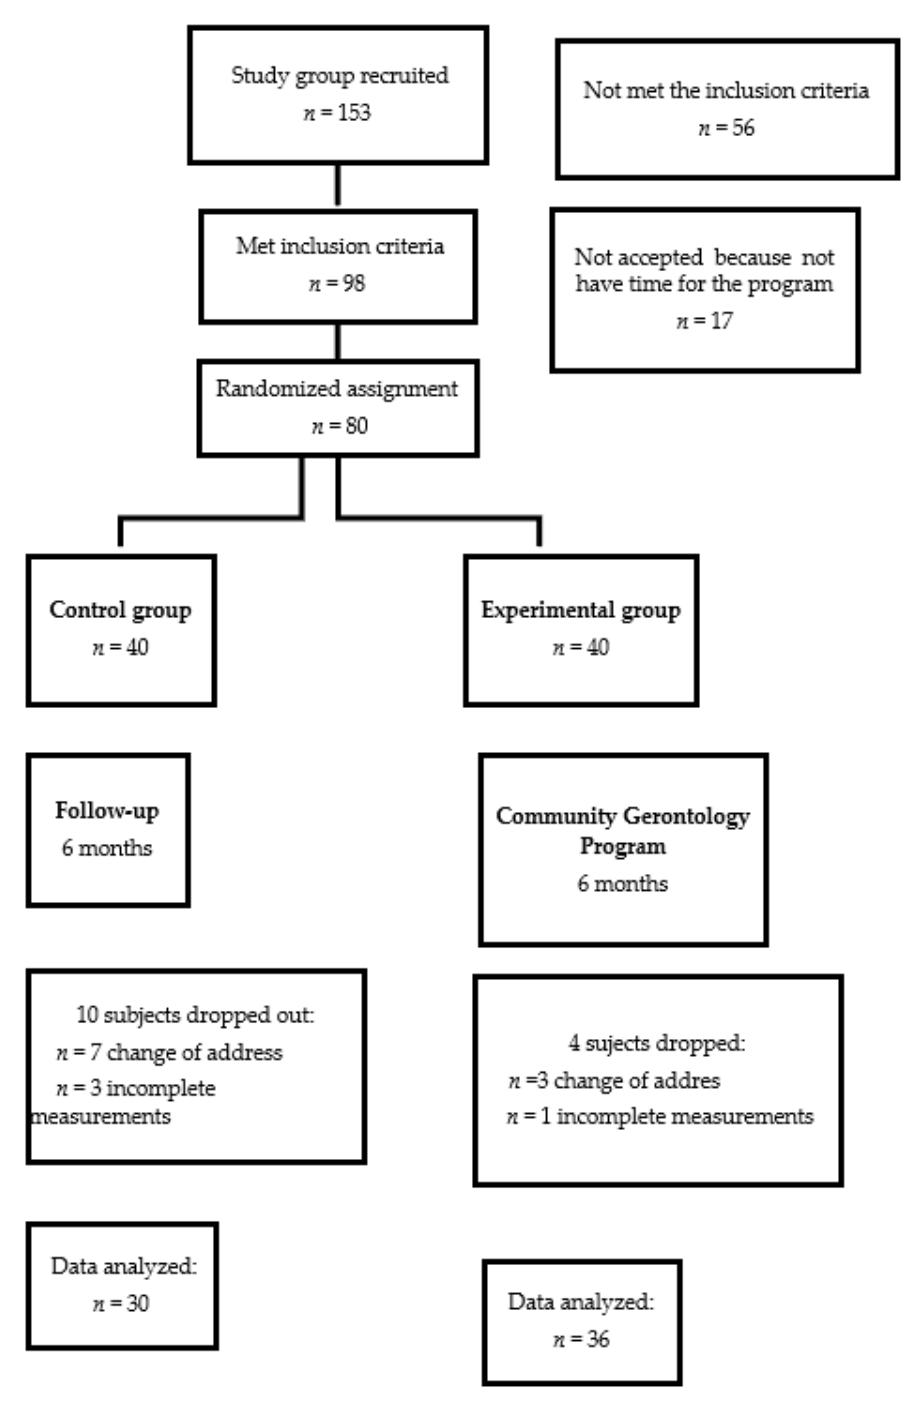
Figure 1. General diagram of the study.